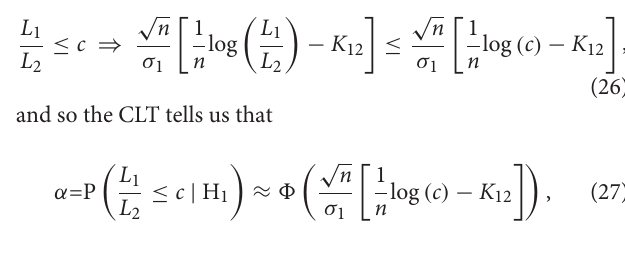
f 1 ( x ) , and H 2 : the data arise from model f 2 ( x ) ) on the